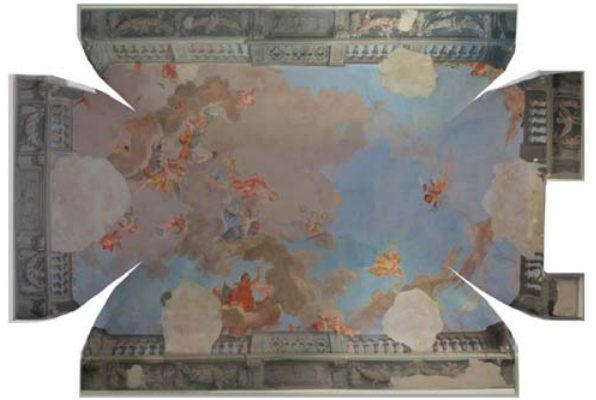
Figure 8 – Frescoed vault belonging to “Palazzo Roncioni”